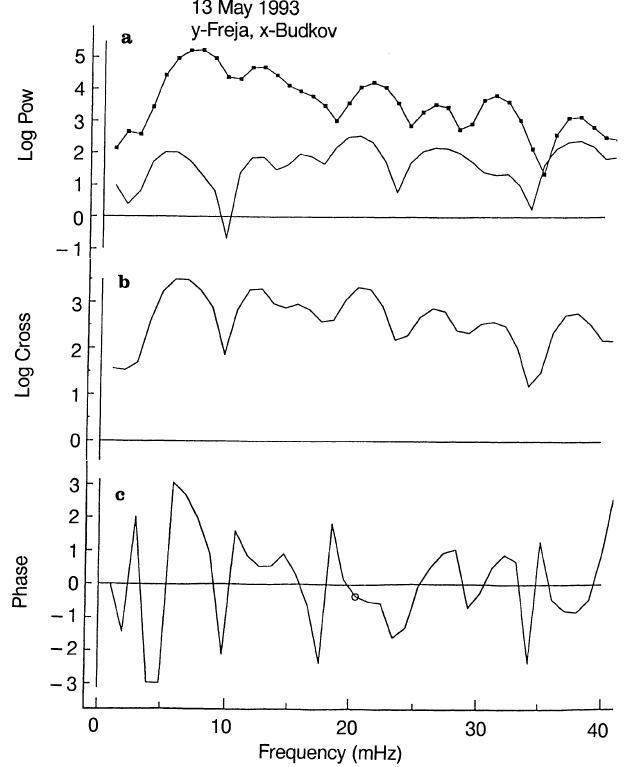
Fig. 7a–c. Frequency dependences for the event of 13 May 1993, analogous to Fig. 2 for y -Freja and x -Budkov records: a the power- spectra, b the real modulus of the cross-spectrum (both on lognT 2 = Hz), c the cross-spectral phase